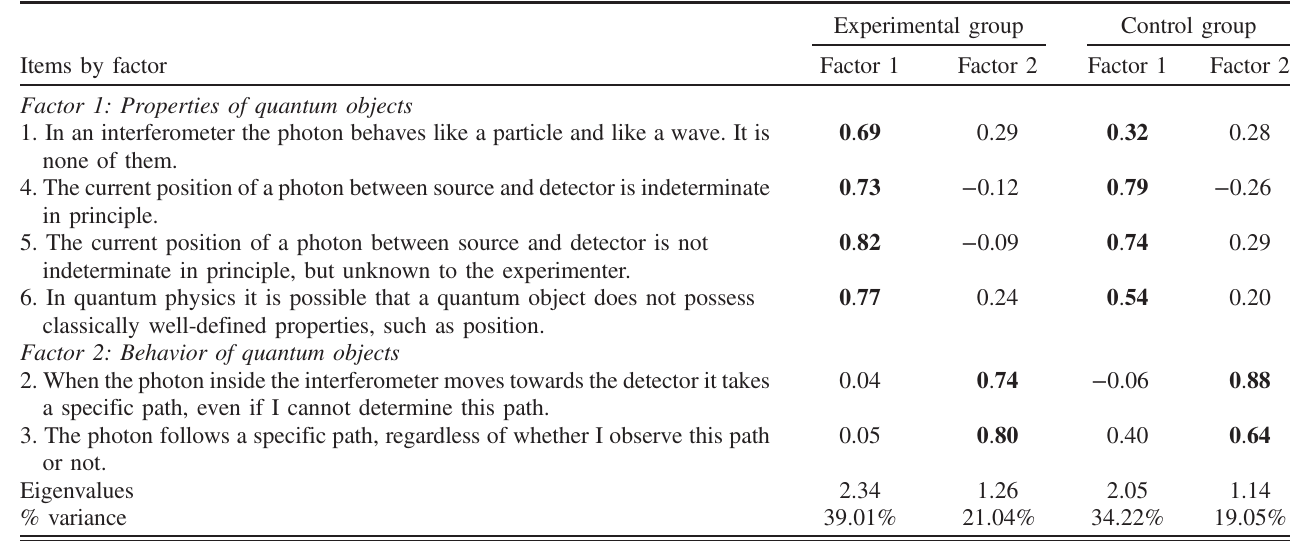
TABLE VI. Factor loadings for our two-factor PCA solution for both datasets from experimental and control group. Retained factor loadings are in boldface for each item per